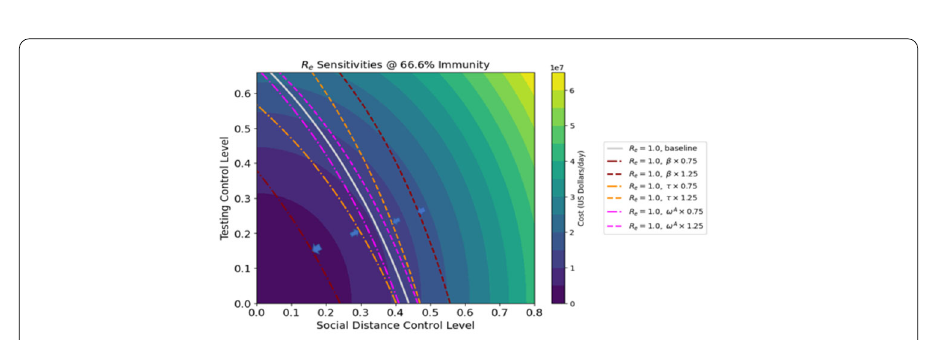
Figure 7 Sensitivity of R e at 66.6% immunity under different values of β , τ and ω A . Blue arrows indicate minimum-cost control solutions for different